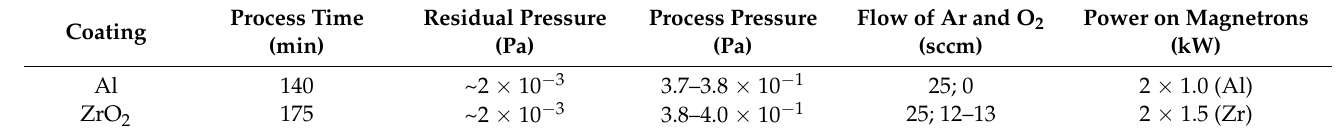
Table 2. Parameters of the MS process.